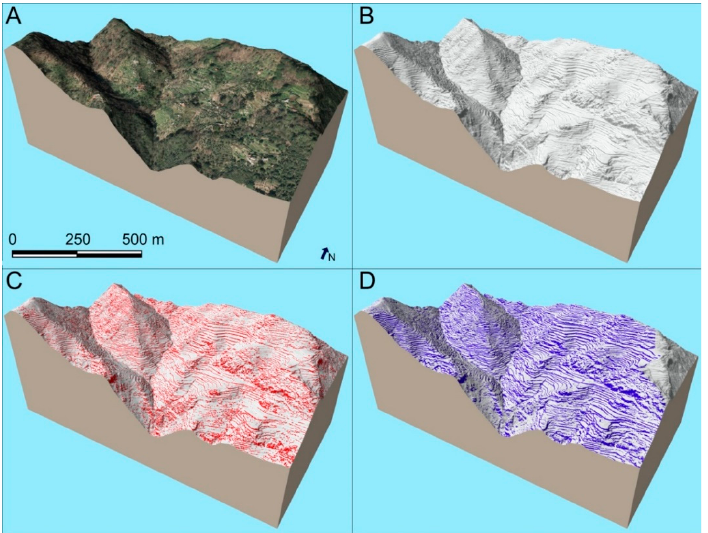
Figure 7. The 3D model showing the detection of terraces in the subarea in the blue box ( α ) in Figure 1. ( A ): the orthophotography; ( B ): the sky-view factor (SKF) visualization; ( C ): both sky-view factor and LUC; ( D ): both sky-view factor and